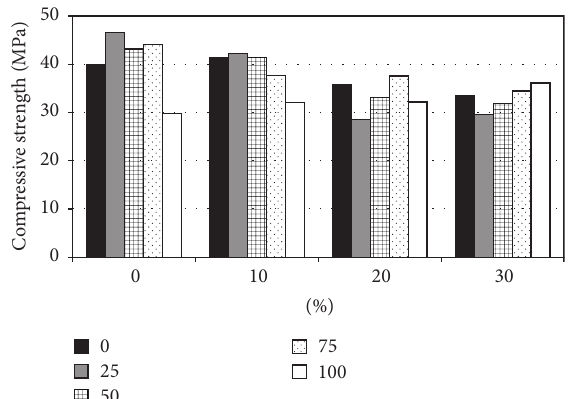
Figure 10: Compressive strength of mortars with FA-WW subjected to freezing